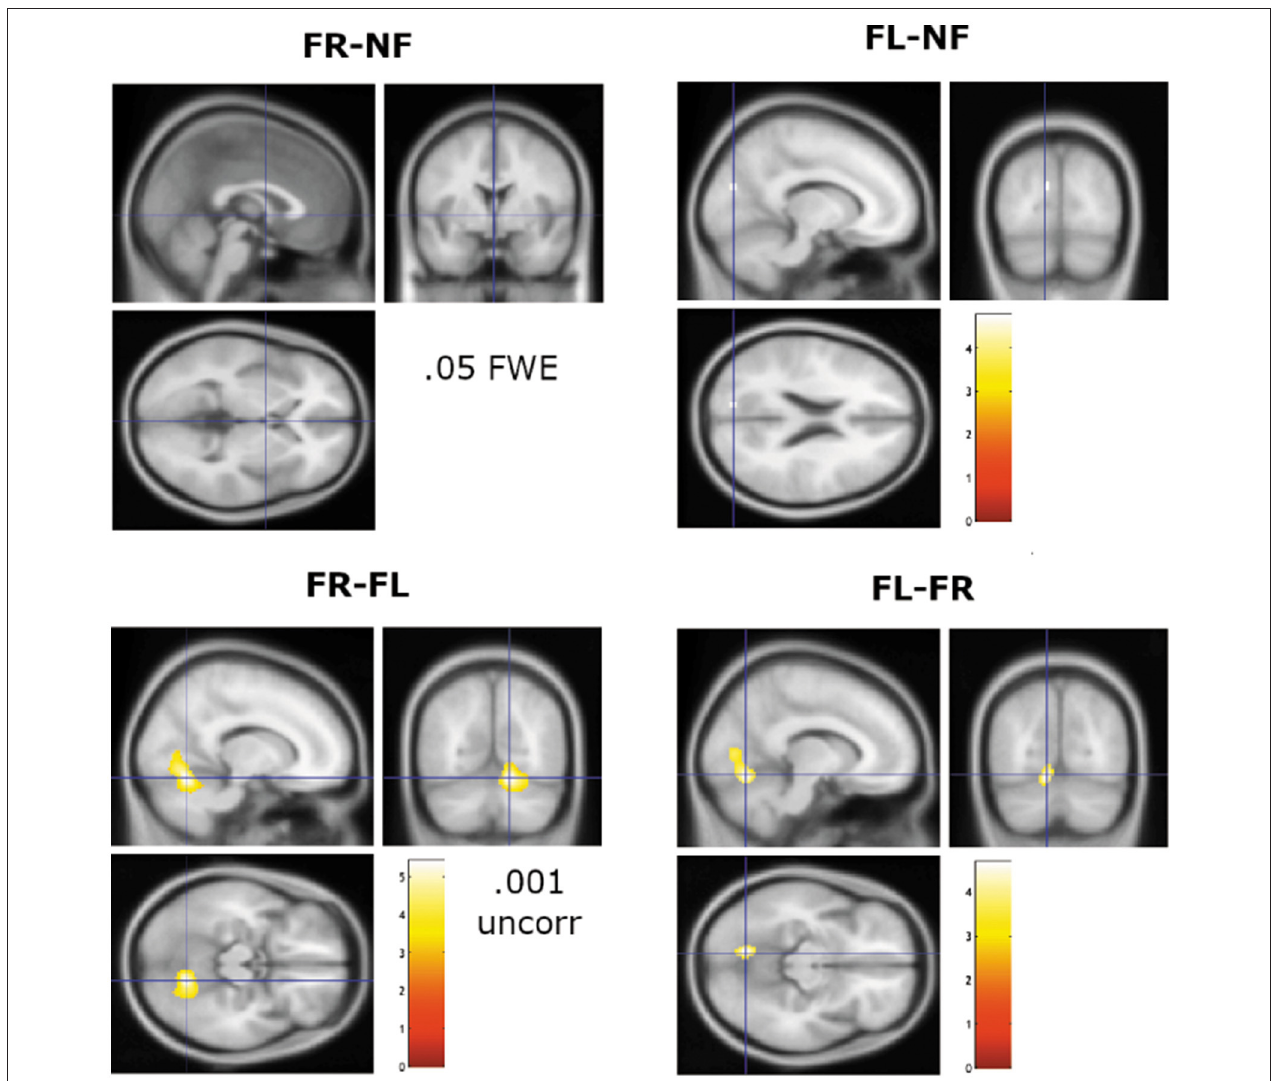
FIGURE 3 | Remaining significant activations when contrasting the FR and FL attention instructions against the NF baseline condition, and against each other. Note lowering of significance threshold to p = 0.001 (uncorrected) for the sections shown in the lower panel. Cross-hair is at x , y , z coordinates 0, 0, 0mm for the FR-NF contrast and at − 12, − 80, 22mm for the FL–NF contrast. For the lower panel, the cross-hairs are placed at 14, − 64, − 16mm for the FR–FL contrast and at − 10, − 70, − 12mm for the FL-FR contrast. Color bar shows t -values.